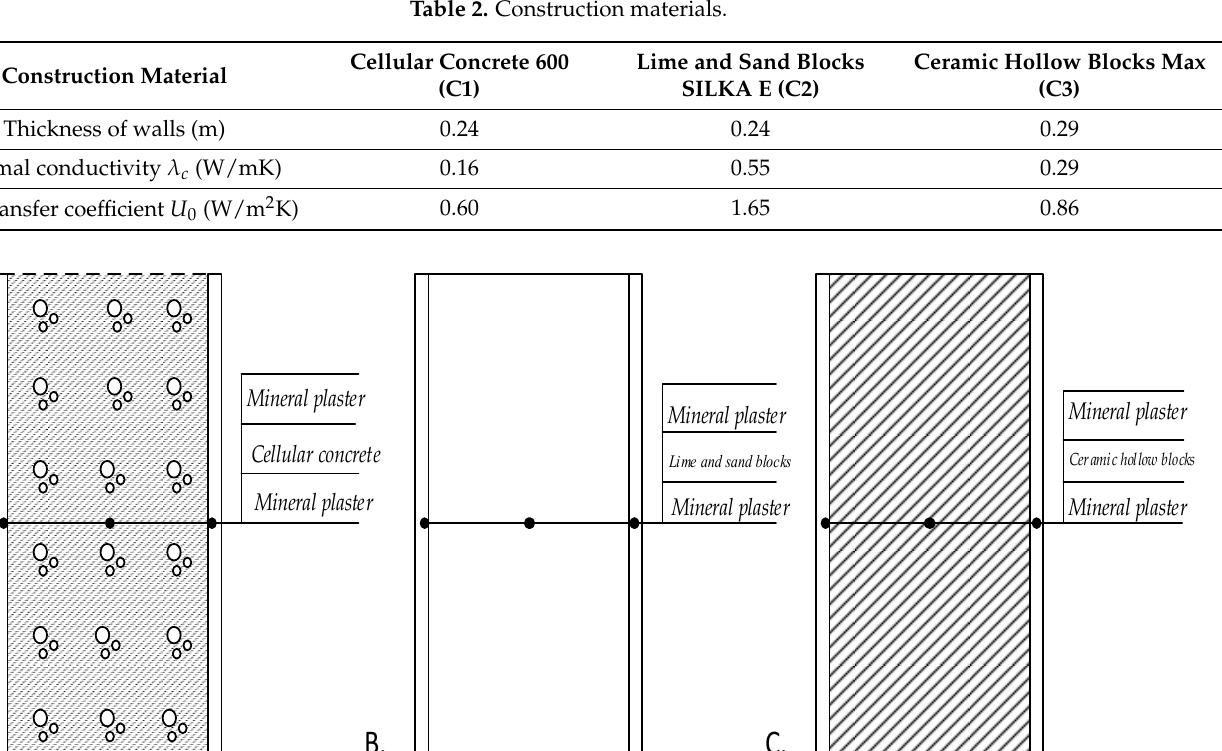
Table 3. Heat sources.